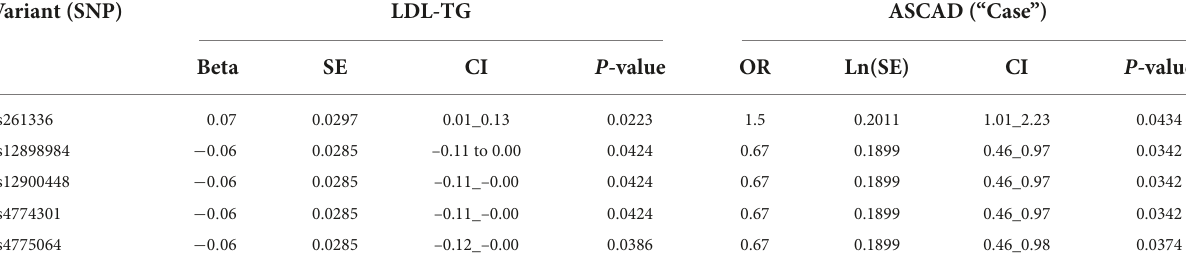
TABLE 2 Genetic association between LIPC gene variants, LDL-TG and atherosclerosis. Variant (SNP) LDL-TG